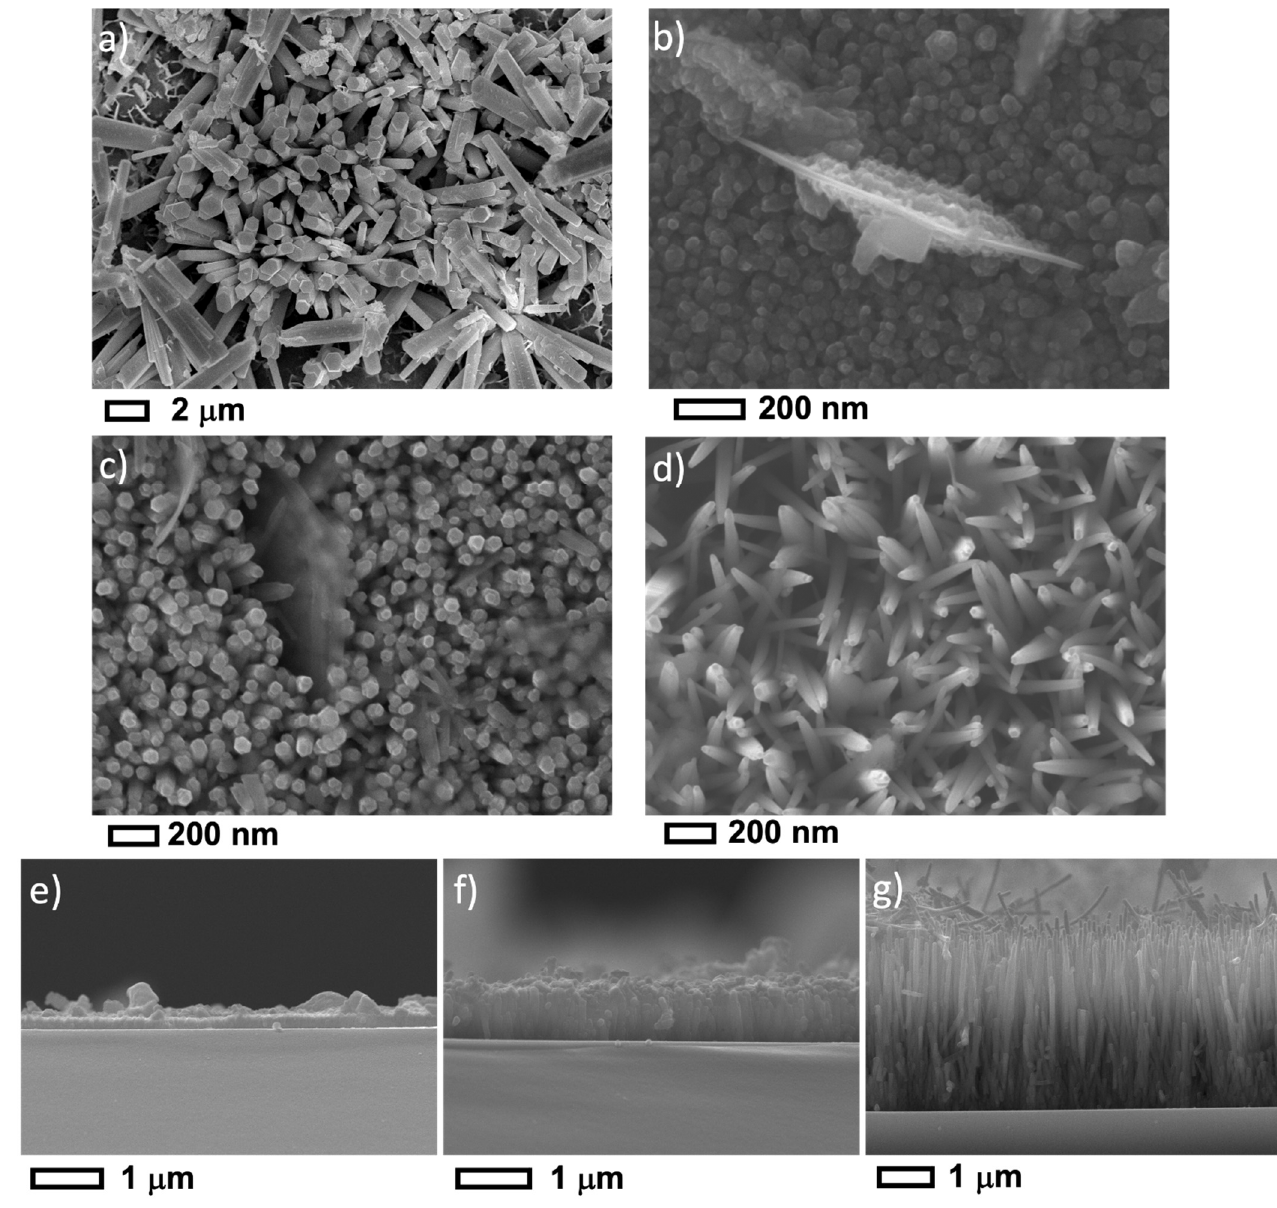
Figure 3. Top view FESEM images for AZO NRs samples: ( a ) AZO I, ( b ) AZO II, ( c ) AZO III, ( d ) AZO IV. Cross-section FESEM images for AZO NRs samples: ( e ) AZO II, ( f ) AZO III, and ( g ) AZO IV.